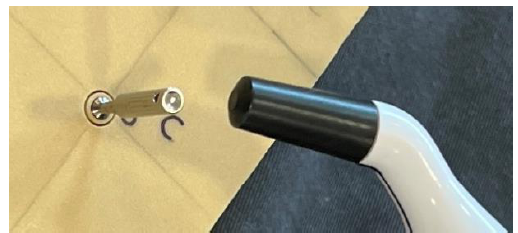
Figure 1. Representative photo of how the measurement were performed. Statistical Analysis